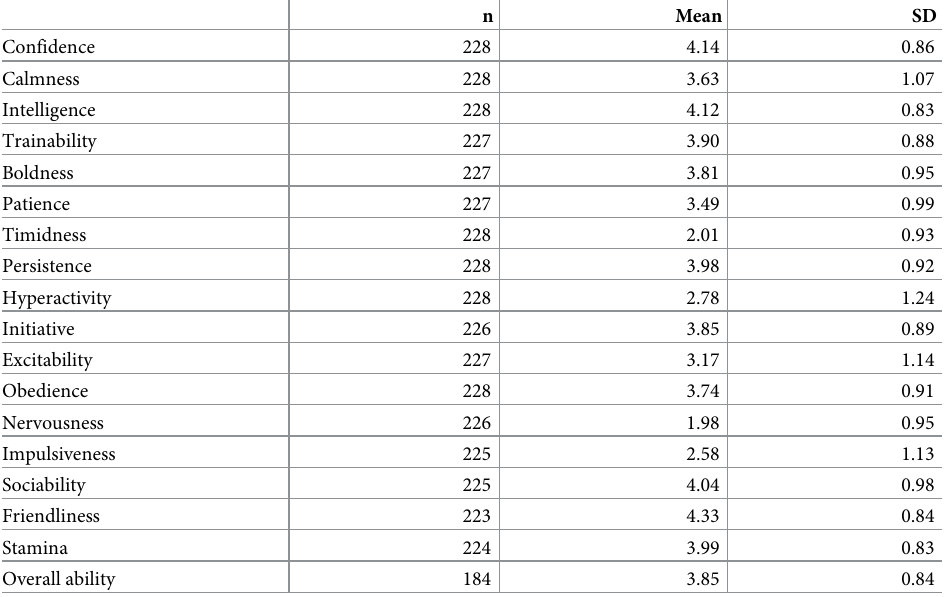
Table 2. Personality trait scores for 228 working Kelpies scored on a scale from 1 to 5 by owners using the HDAF-P, the number of dogs for which a score was given and the mean and standard deviation of scores given for each